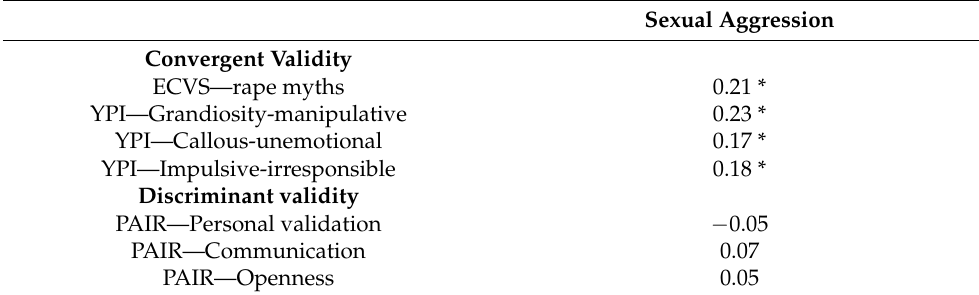
Table 3. Correlation Values between the SABS, ECVS, YPI, and PAIR dimensions.